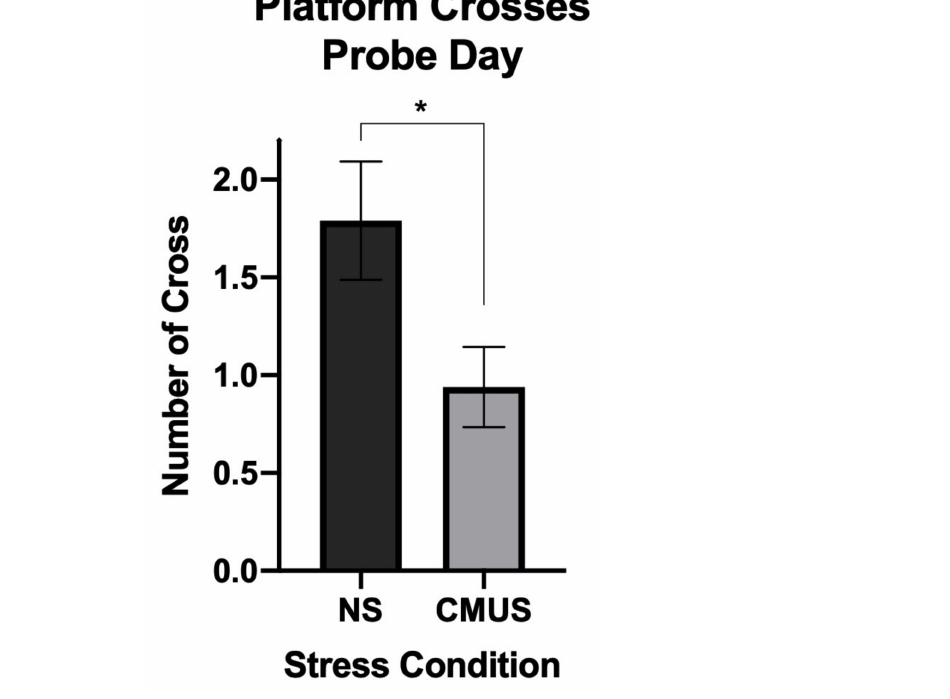
Figure 10. Number of platform crosses on the 24 h Probe Day (Day 7). Mice experiencing CMUS made significantly fewer crosses over the submerged platform as compared to mice experiencing no stress (NS) (* p < 0.05).